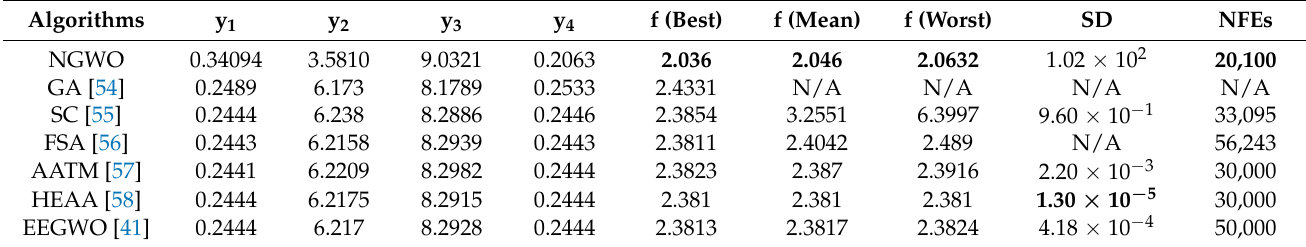
Table 6. Comparative study of Welded Beam design problem.